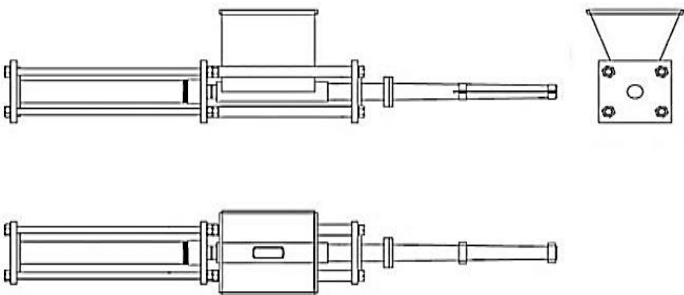
Figure 7. Hydraulic piston briquetting unit.